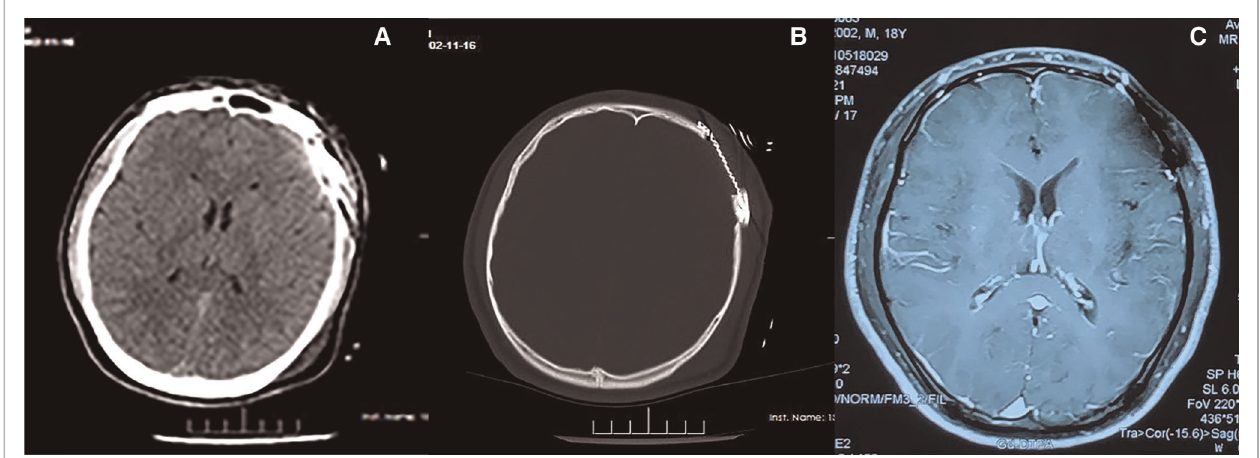
FIGURE 3 | Imaging information were followed up one year after surgery of LCS ( A,B ) CT ( C )